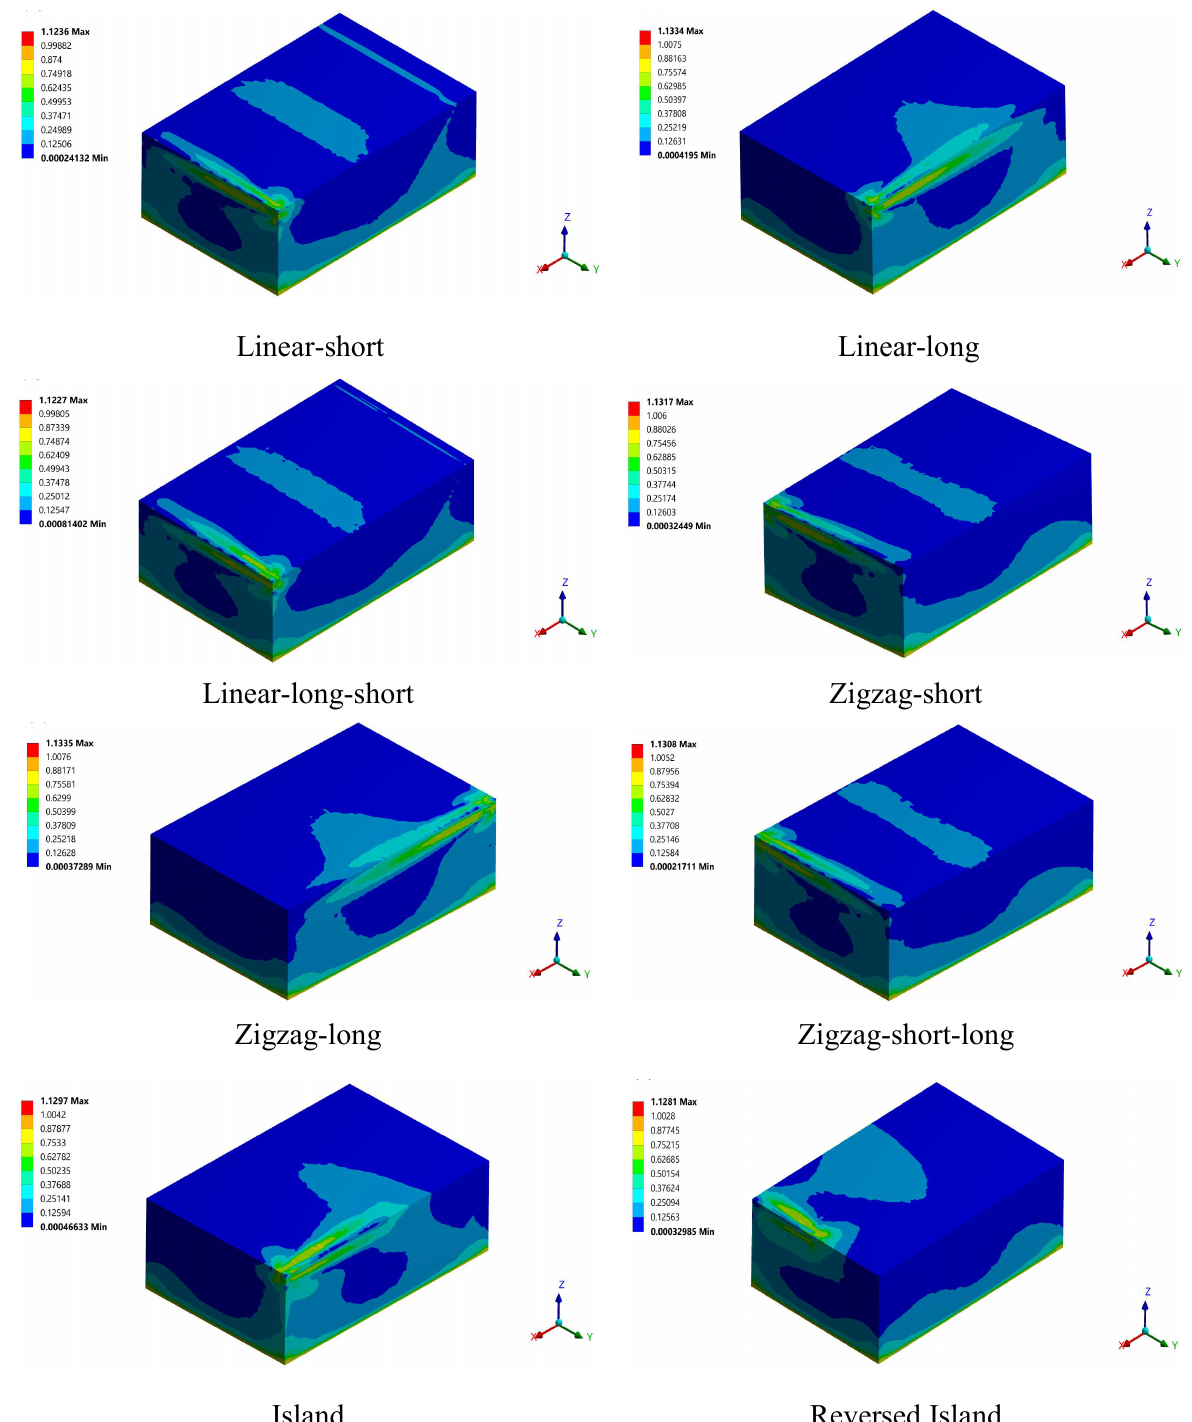
Figure 13. Normalized von Mises stress for the studied build ordinations just after solidification.